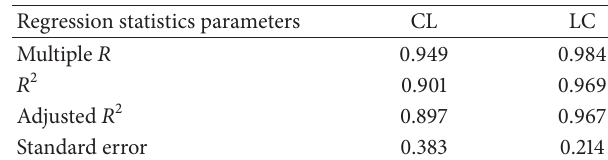
Figure 5: Cumulative distribution function of fracture toughness. Table 2: Multiple regression model parameters for predicting fracture toughness ( 𝑃 < 0.001 ).